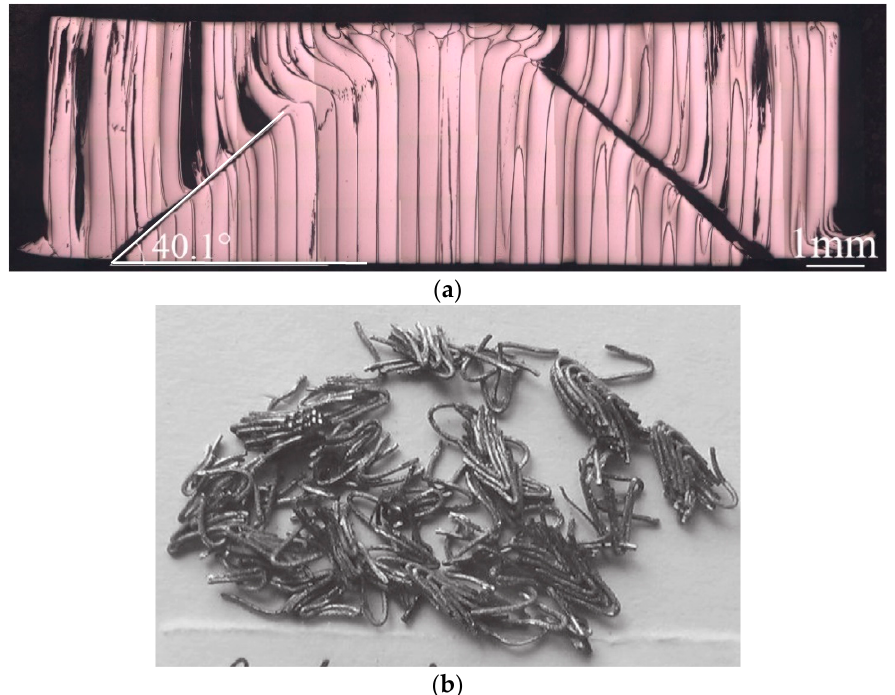
Figure 10. Deformation modes of WF/Zr-MG under dynamic compression [4,5]. ( a ) Under room temperature; ( b ) Under 773 K.